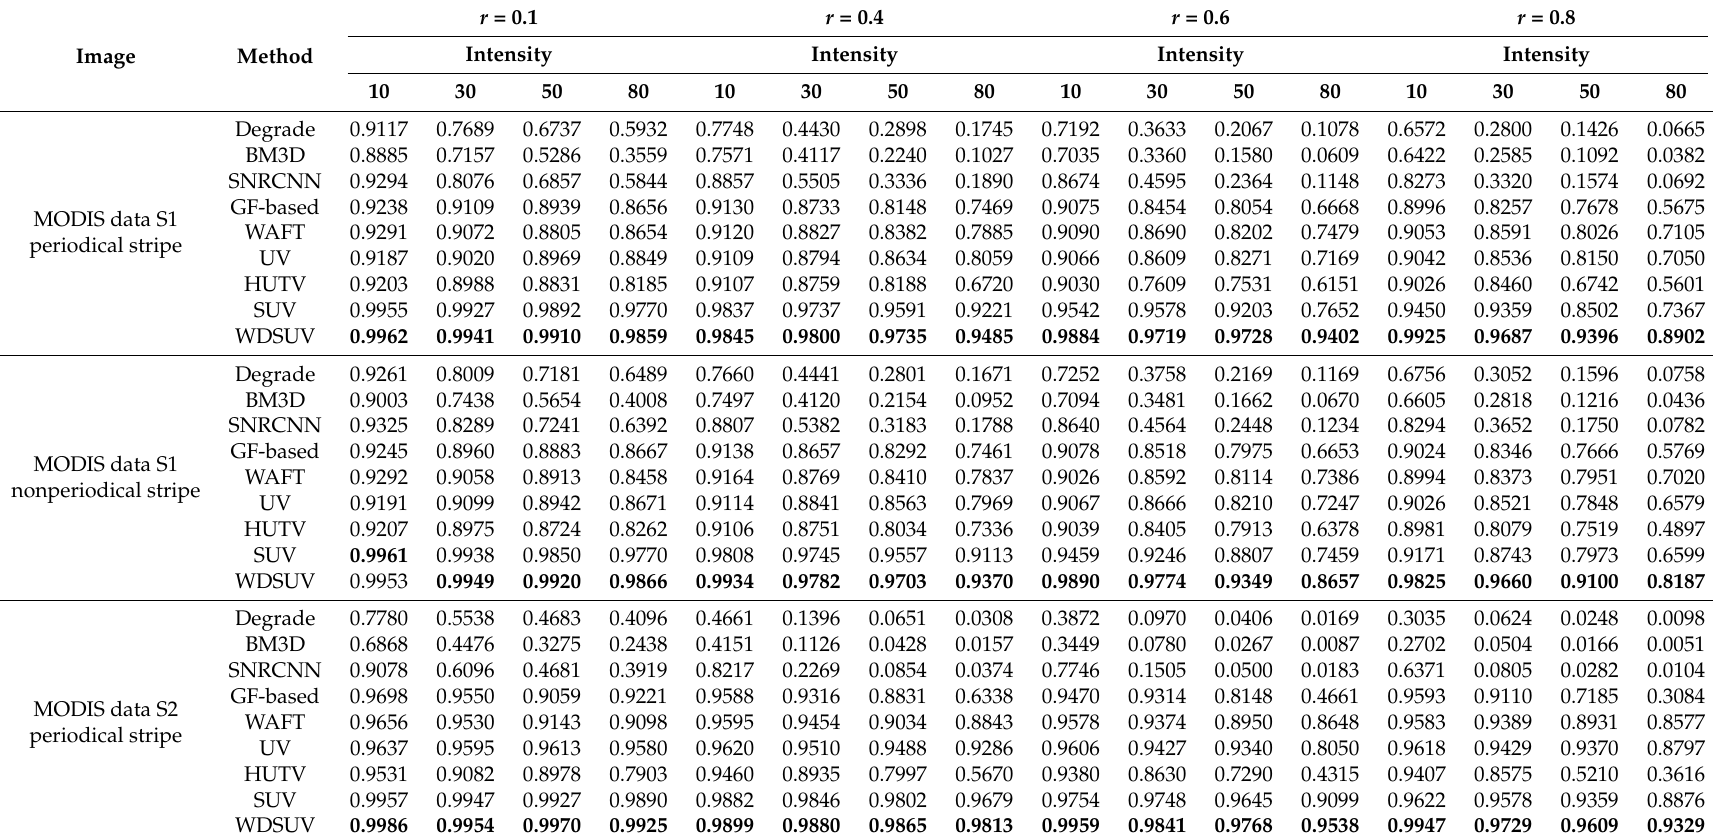
Table 3. Structural similarity index (SSIM) index results of different methods on simulated data under various noise